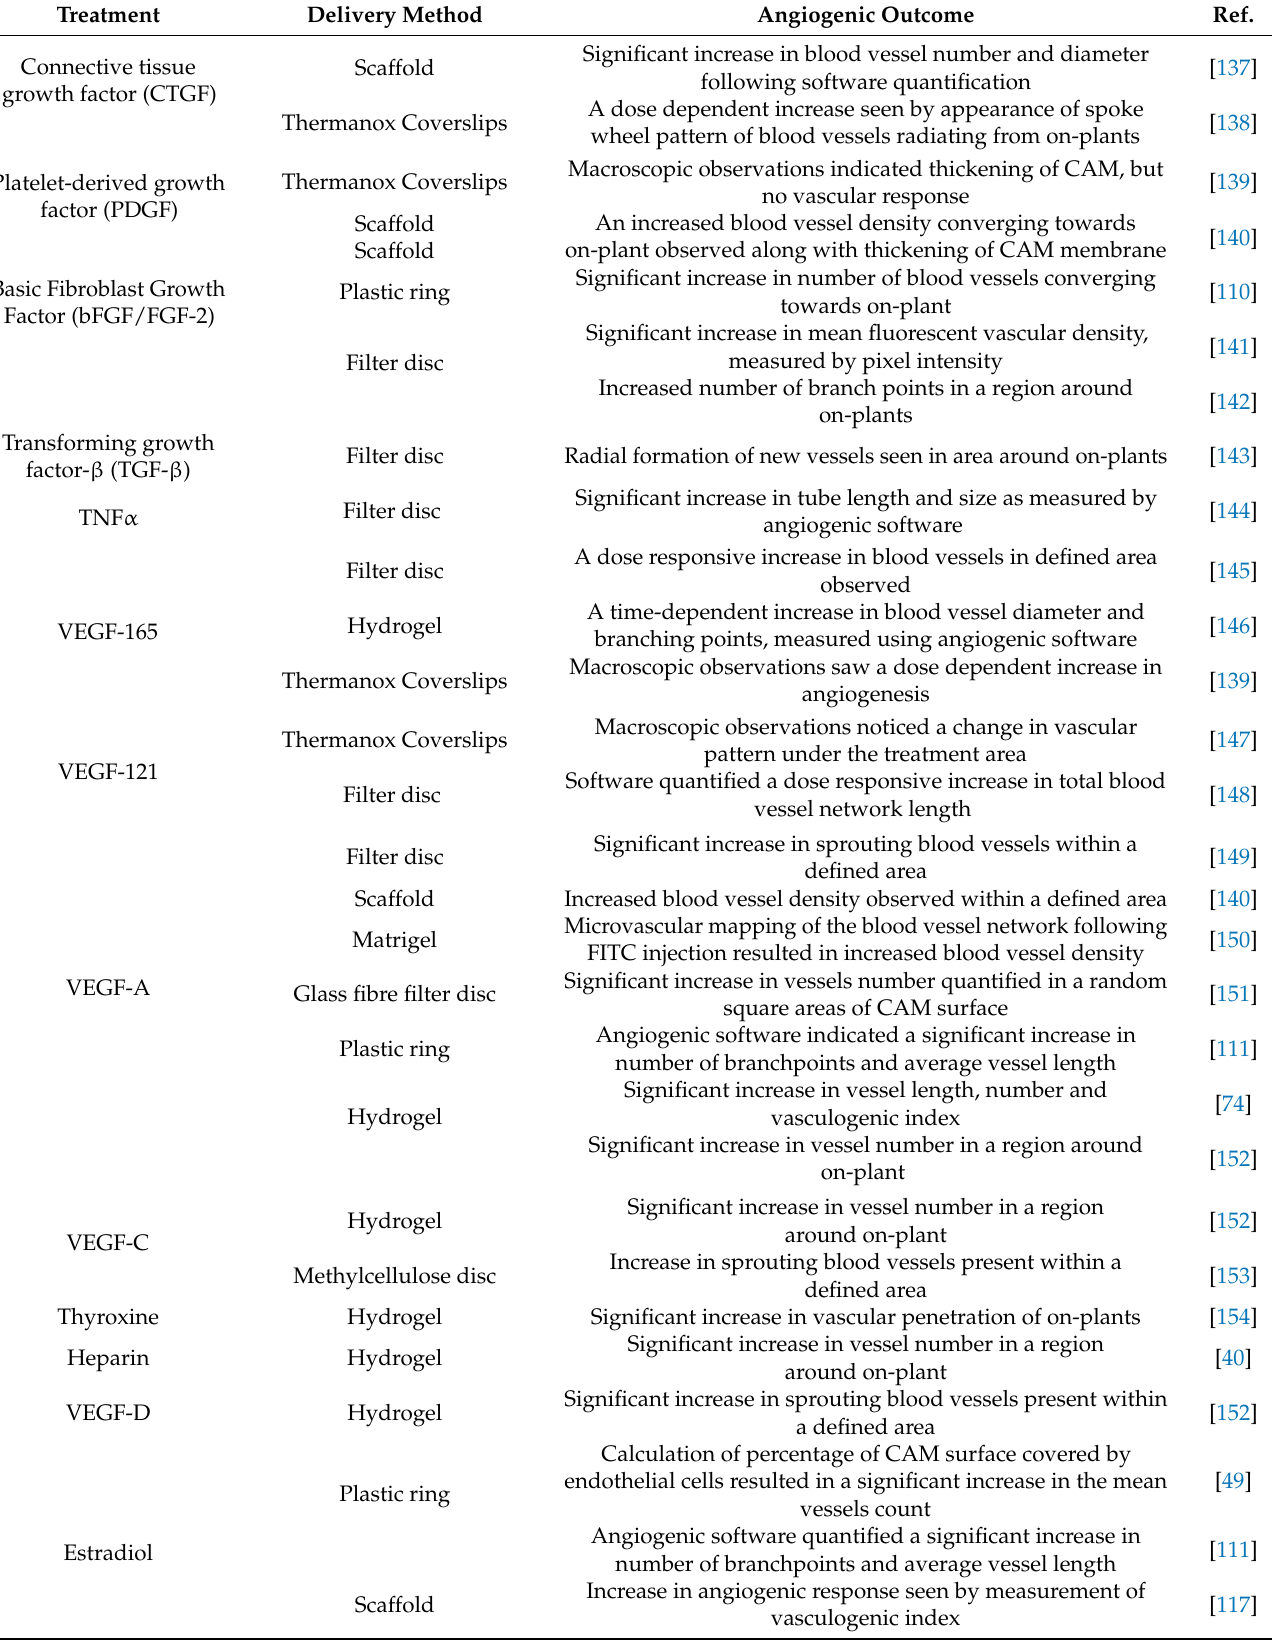
Table 2. Examples of non-cellular treatments applied to the CAM which elicited a pro-angiogenic